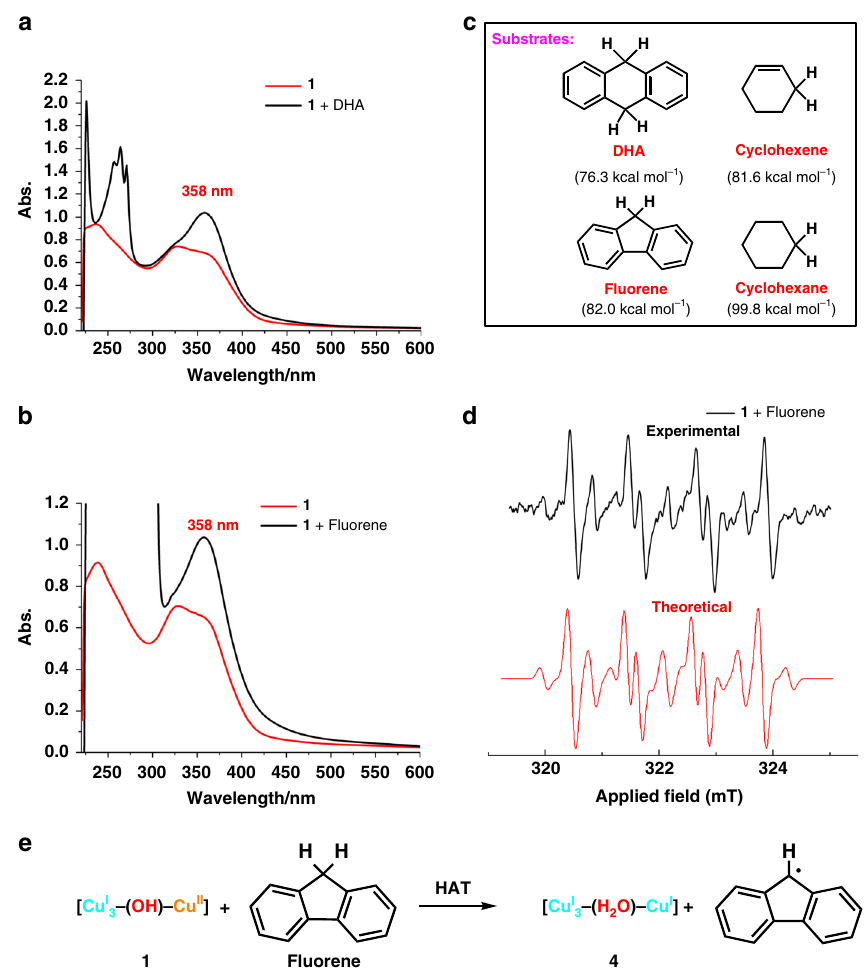
Fig. 7 HAT studies of complex 1 . UV-vis spectra of 1 and the products after reacting with a DHA and b fl uorene. c HAT substrates with different BDEs. d EPR measurement for capturing the radical products in the reaction between fl uorene and 1 in DMSO. 5,5-Dimethyl-1-pyrroline N-oxide was used as a radical trapper. e The alkyl radical generation process between 1 and fl